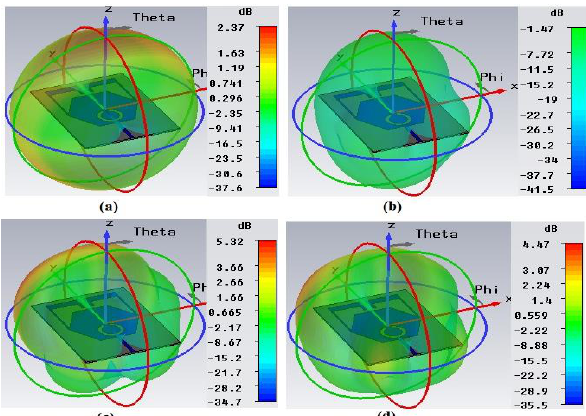
Figure 13 : 3D plot of field pattern shows the gain at : (a) 2.4GHz ; (b) 5.75GHz ; (c) 7.5 GHz ; (d) 8.5GHz. These figures show that integrated Bluetooth band in UWB hexagonal antenna with notch band keep the properties of UWB in the term of gains.